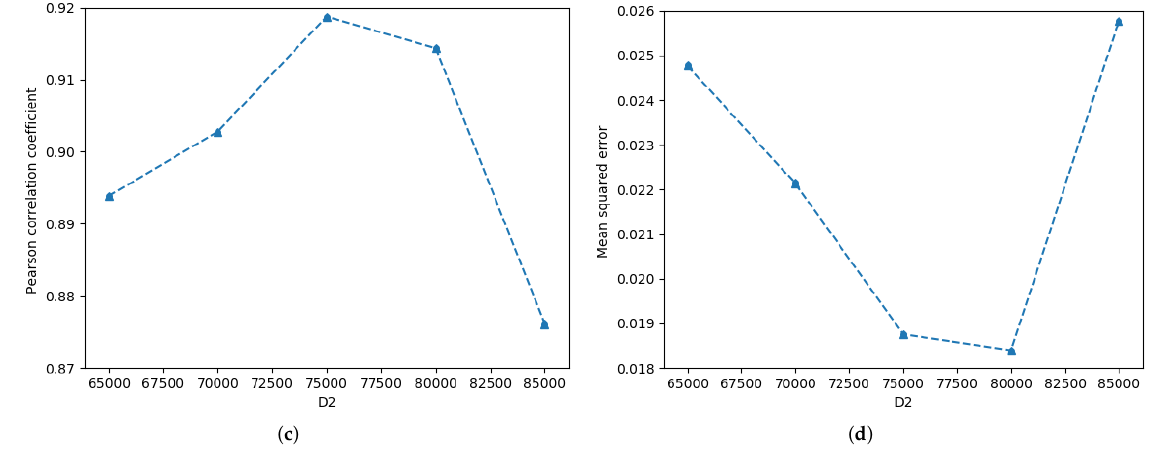
Figure 5. Detailed influence of the D 1 and D 2 on semantics of STS’15.images.txt. ( a ) Pearson correlation coefficient- D 1 , ( b ) Mean squred error- D 1 , ( c ) Pearson correlation coefficient- D 2 , ( d ) Mean squred error- D 2 .